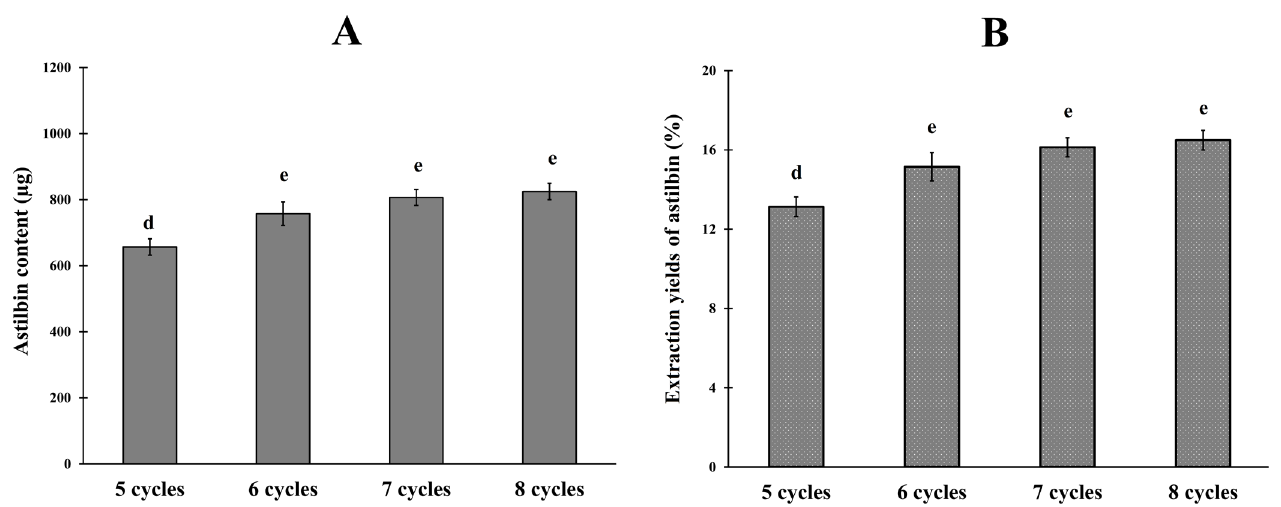
FIGURE 6 - (A) Astilbin content and (B) extraction yields of astilbin using 450 W of microwave power in water:methanol (40:60) solvent using a different number of microwave-assisted extraction cycles. The extraction yields of astilbin were calculated as